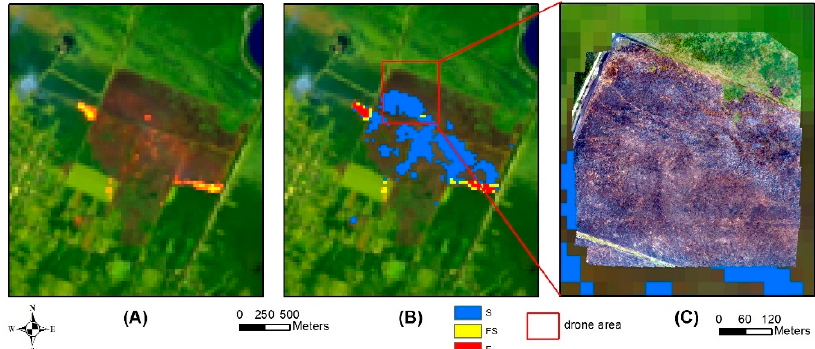
Figure 10. ( A ) The 764 RGB image of Landsat-8 on 28 September 2018 and ( B ) the result of peatland combustion mapping with ground truth location marked in red square, ( C ) The picture of peatland smouldering fire taken from a drone on 1 October 2018.